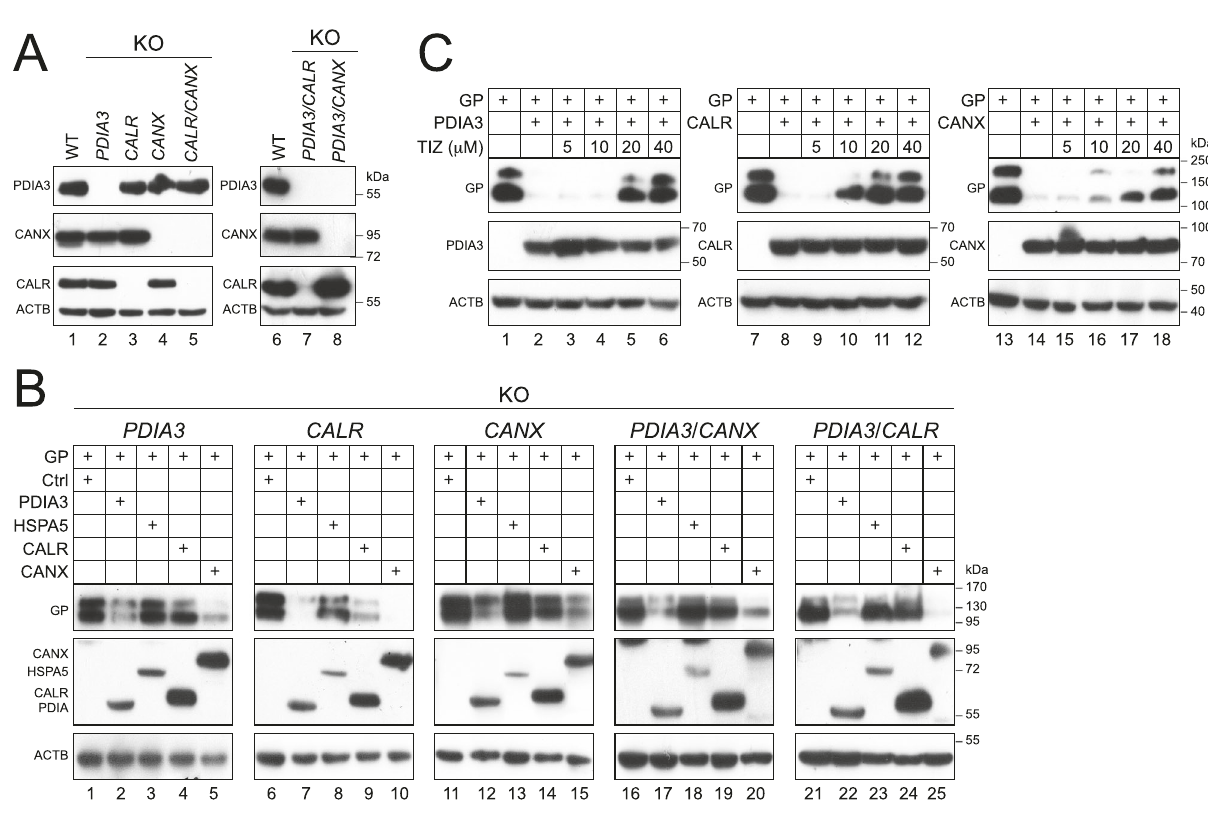
Fig. 3 | Interrelationship between CANX, CALR, and PDIA3 in EBOV-GP 1,2 (GP) downregulation. A Expression of PDIA3, CALR, and CANX was determined in HEK293T WT, single PDIA3 -, CALR -, or CANX -KO, and dual PDIA3 / CALR - or PDIA3 / CANX -KOcells.ProteinexpressionwasdeterminedbyWB.PDIA3,CALR,and CANX were detected by their speci fi c antibodies. B GP was expressed with indi- cated ER proteins in HEK293T WT and indicated KO cells. Protein expression